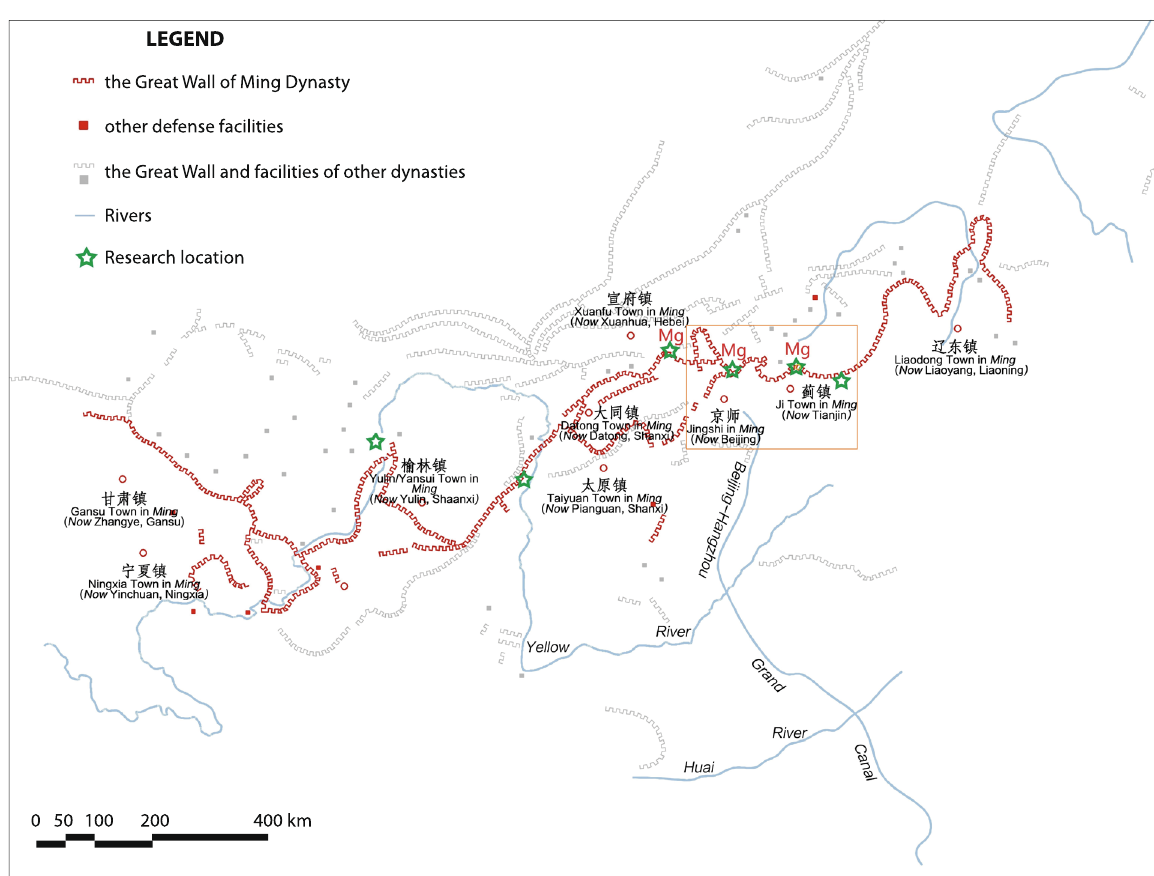
Fig. 1 Map of the Ming Great Wall with sampling points (green stars) and dolomitic lime binder (red “Mg”). The Ming Great Wall in the yellow square frame was built under the former Ji Town administration (Source: Tongji-ACL, revised based on Wang